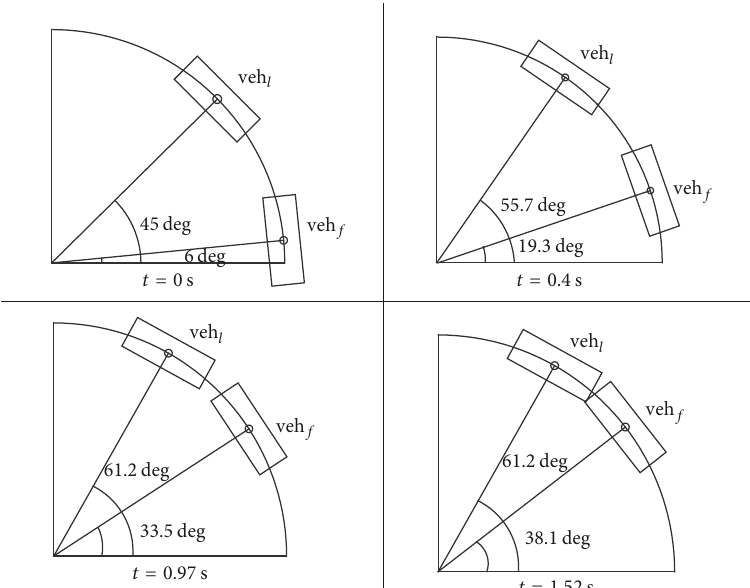
Figure 2: Time-lapse sequence of two left-turning vehicles, with ABS-engaged braking trajectories. Parameters: 𝑟 = 50 󸀠 , 𝛽 𝑙 = 45 ∘ , and V = 20 mph.